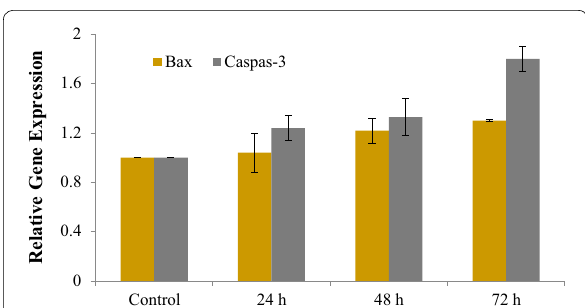
Fig. 8 The effect of L. usitatissimum on the expression of caspase-3 and Bax ratio in LNCaP cells evaluated using the Real-Time PCR method. Cells were treated with the IC 50 dose with the extract. The significant difference between control groups with Treatment group is indicated ; * p < 0.05, ** p < 0.01 and *** p < 0.001. IC 50 doses at different times: 24 h: 8.3 μg/mL; 48 h: 6.3 μg/mL and 72 h: 5.4